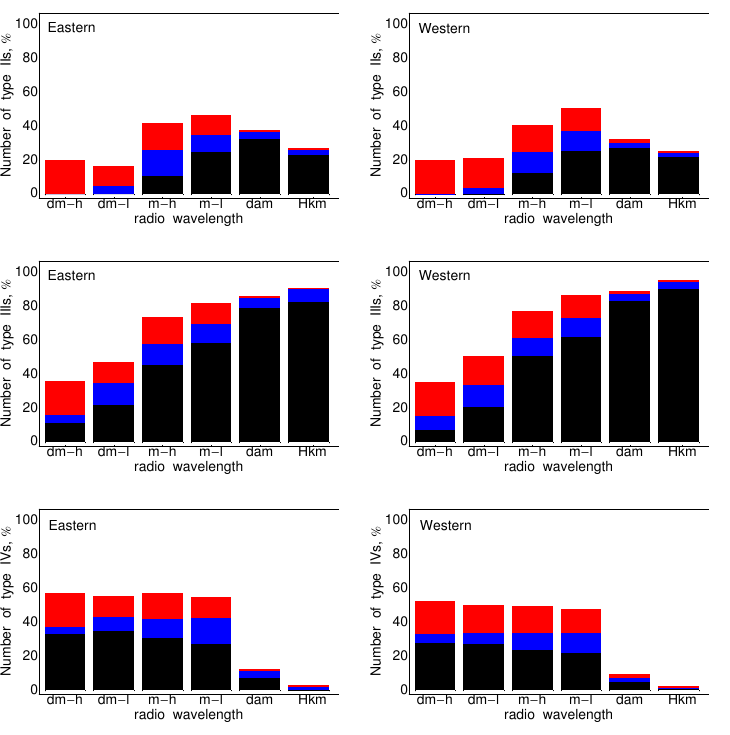
Figure 3. Plots of type II ( top ), III ( middle ) and IV ( bottom ) radio bursts, normalized to 184 Eastern (on the left ) and 623 Western (on the right ) SEE events. Color code as in Figure